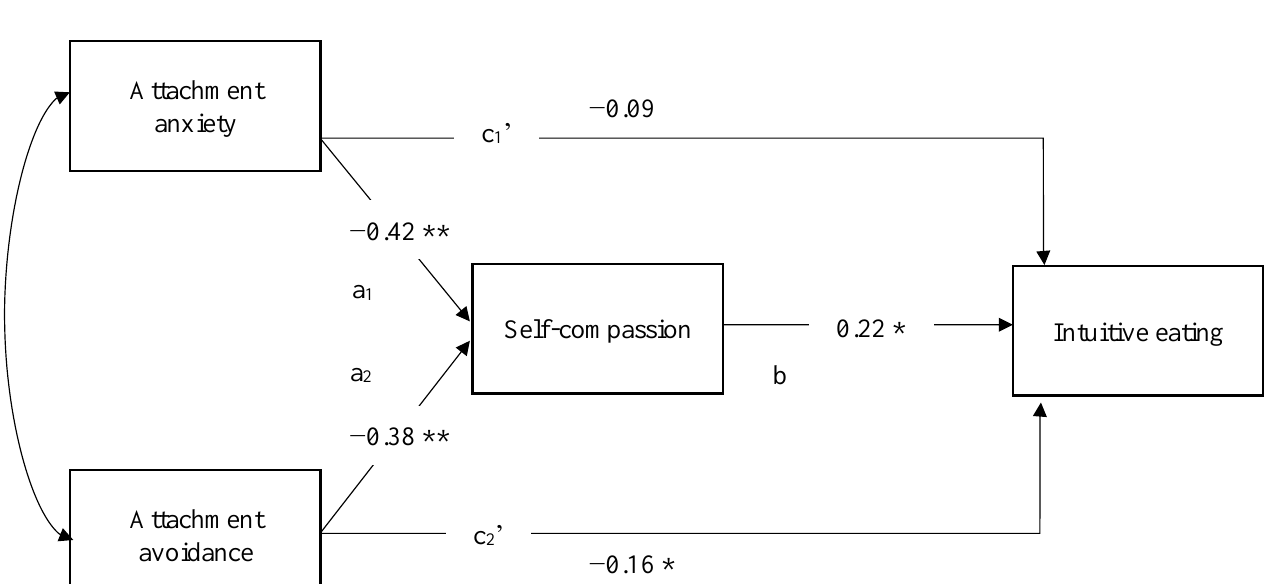
Figure 1. Structural Equation Model demonstrating the direct and indirect paths between attachment and intuitive eating. N = 201; * p < 0.05, ** p < 0.01. Curved arrow represents variables that are allowed to covary; solid lines represent direct